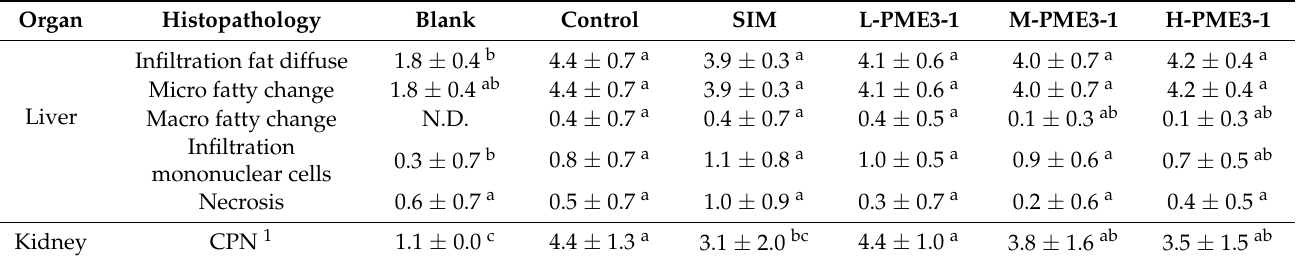
Table 4. The effects of PME3-1 on histopathological changes of livers in high fat and cholesterol diet in